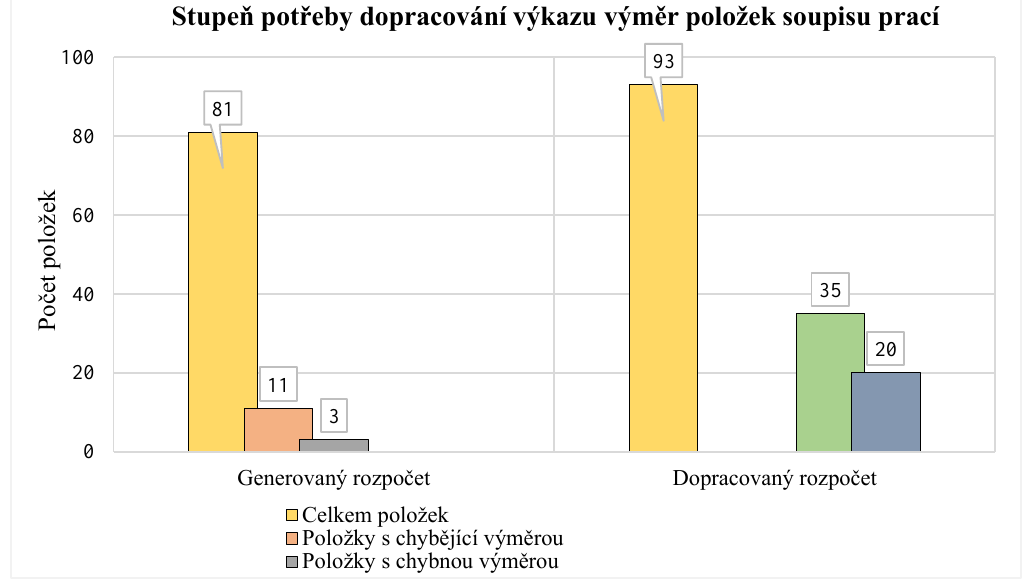
Skupina - úplnost výkazu výměr Zhodnocení míry potřeby dodatečného doplnění výkazu výměr vybraných položek generovaného stavebního rozpočtu vyjadřuje sloupcový Graf 2. Schéma přitom rozlišuje konstrukční a materiálové položky, v jejichž případě došlo k přenosu neúplných strojově transformovaných ne-geometrických parametrů v podobě, kde položky měly výkaz výměr nulový. Bylo nezbytné výměry s využitím BIM modelu dopracovat. Realizace dodatečného doplnění výkazu výměr byla nevyhnutelná rovněž v okamžiku nasazení a importu nových položek.